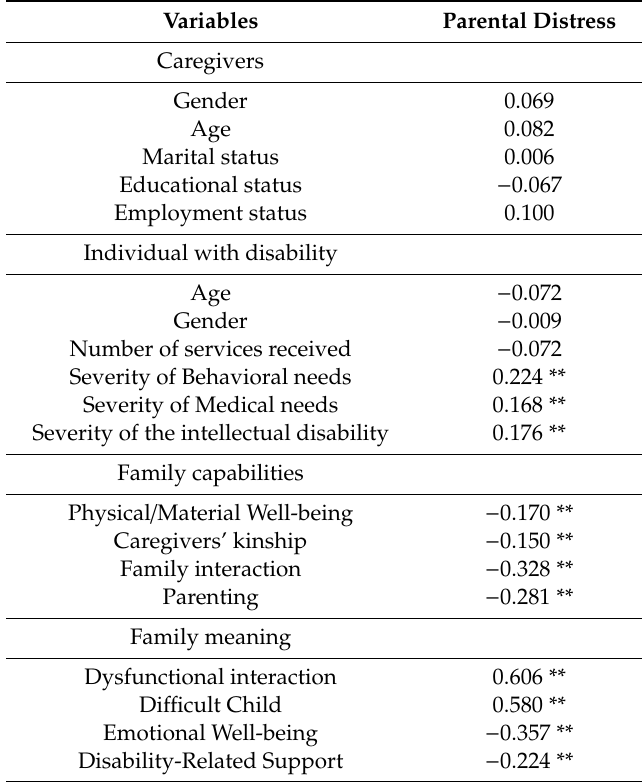
Table 3. Pearson’s correlation between selected variables and scores on Parental